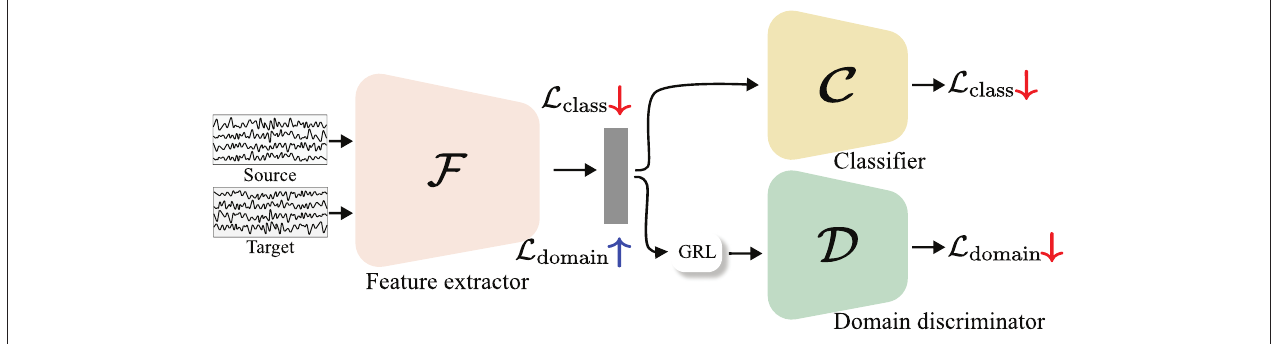
FIGURE 8 | Illustration of domain adversarial neural network (DANN) (Ganin et al., 2016). L class and L domain denote a classification loss and domain loss, respectively. Through a GRL where gradients of a domain loss are reversed by multiplying a negative value, a domain loss is minimized in a domain discriminator and maximized in a feature